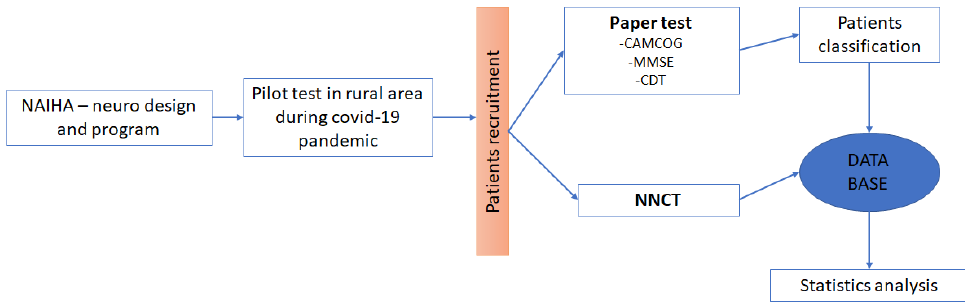
Figure 1. Sequence of the procedure. In this image, we can see the sequence of the com- from the design of the programme to the analysis of the plete project, from the design of the programme to the analysis of the results